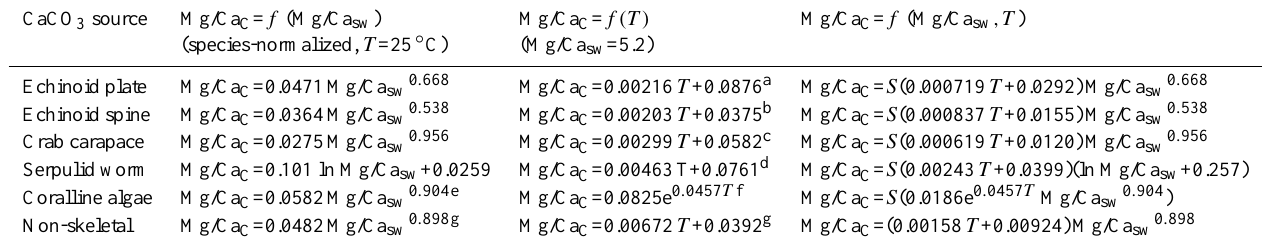
Table 2. Algorithms relating Mg/Ca sw , Mg/Ca C , and